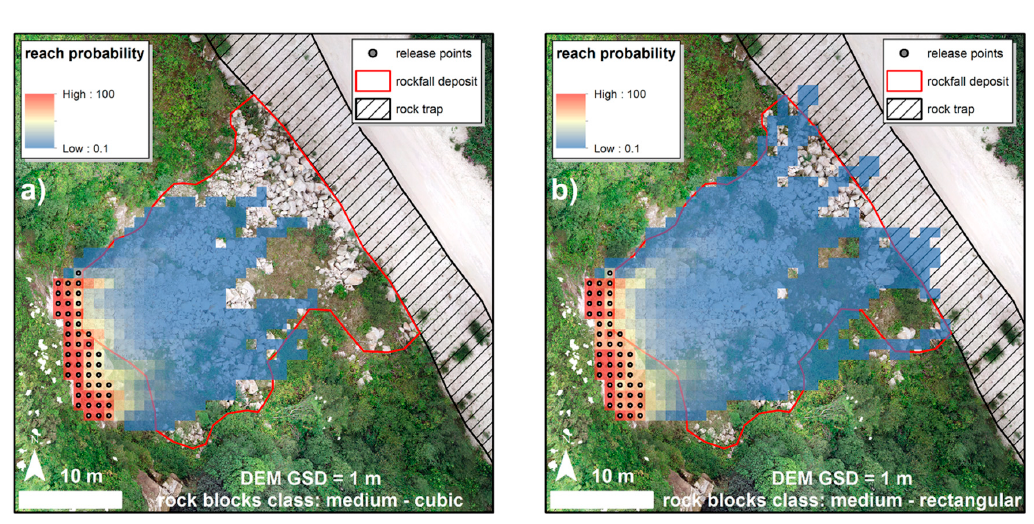
Figure 13. Comparison of reach probability layers showing the effect of block shape; panel ( a ) shows the runout of equidimensional (cubic) blocks, while panel ( b ) shows the runout of elongated (rectangular) blocks. Rock block classes’ properties are summarised in Table 5.